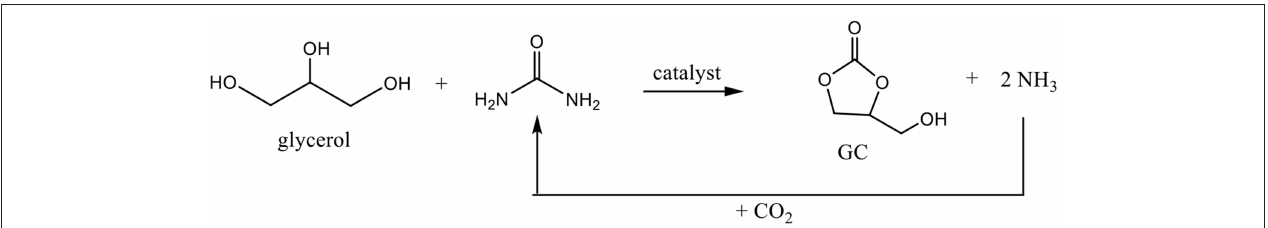
FIGURE 6 | Reaction of glycerol in presence of urea and urea synthesis from NH 3 and CO 2 .